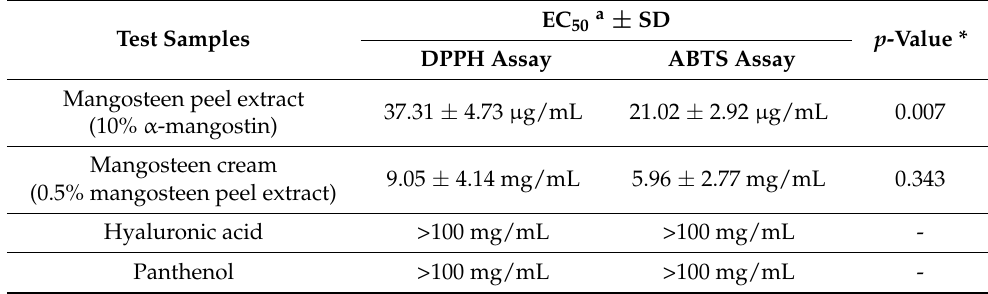
Table 6. Antioxidant capacity of test